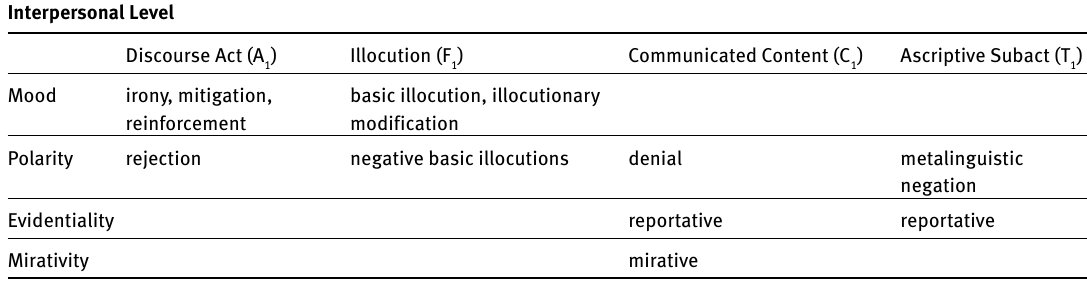
Table 1. Tense, aspect, mood, evidentiality, mirativity, polarity, and localization in FDG Interpersonal